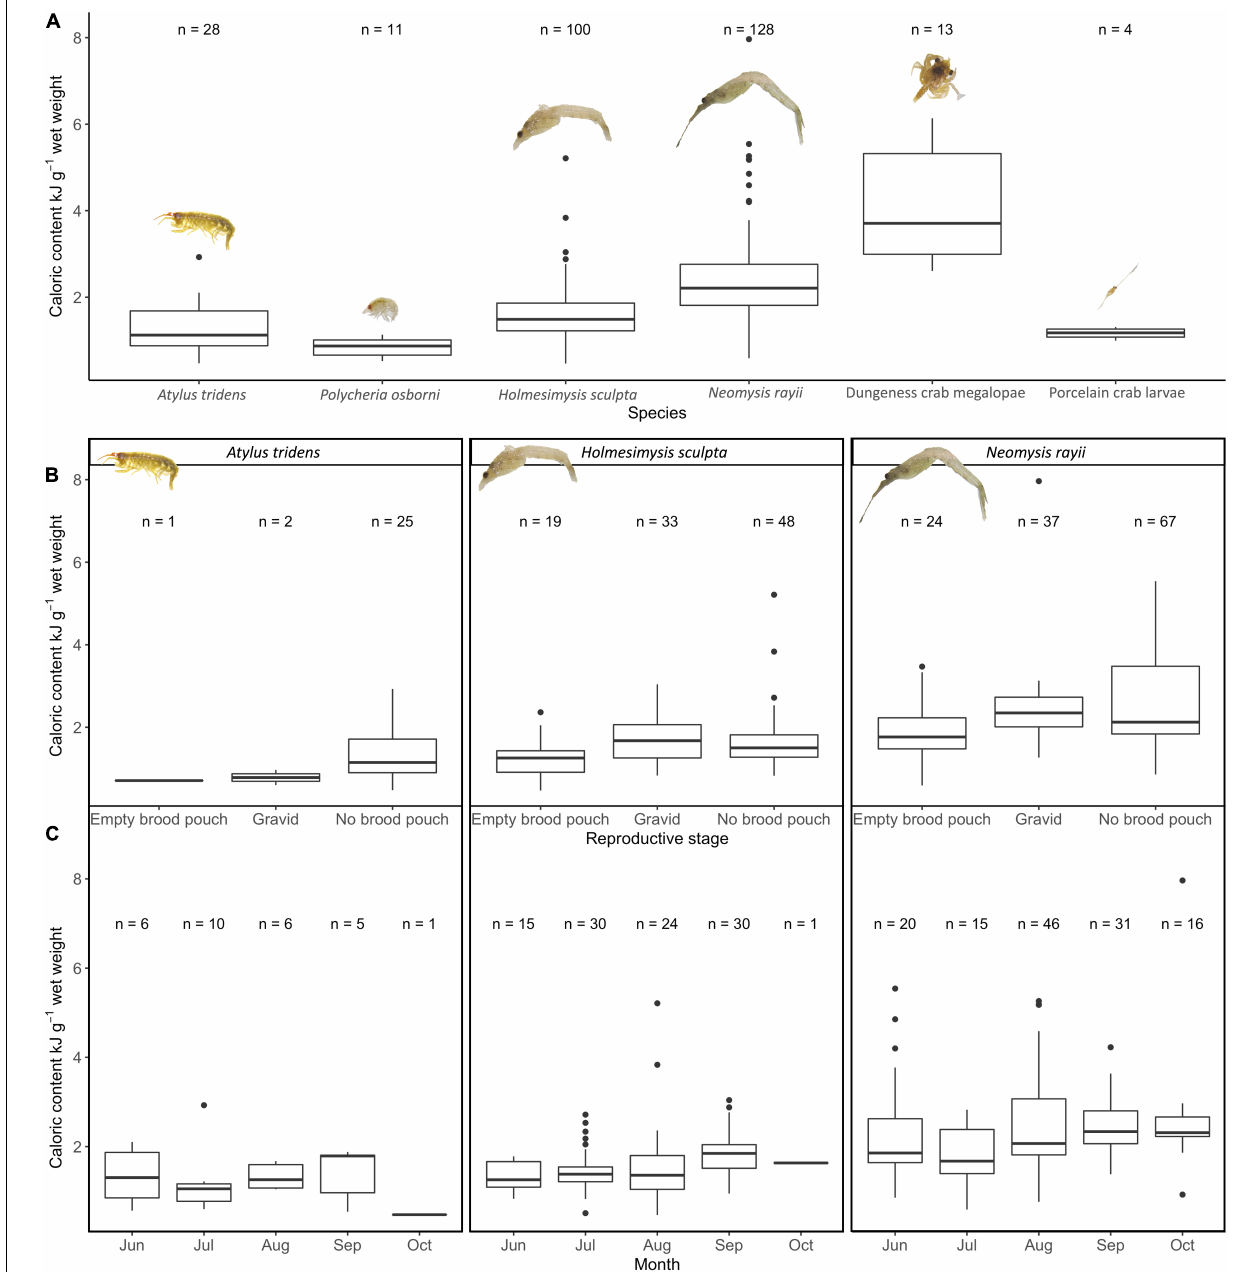
FIGURE 2 | Median caloric content and interquartile ranges (kJ g - 1 wet weight) by (A) species, (B) reproductive stage, and (C) month. Sizes of the zooplankton images are scaled at actual ratios relative to one another.